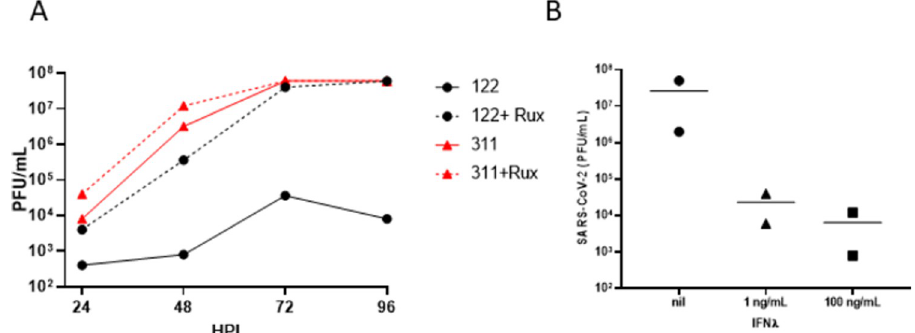
Fig 4. IFN signalling mitigates SARS-CoV-2 growth kinetics. WD-PNECs derived from donor 122 and SARS-Cov- 2-permissive donor 311 were treated basolaterally with 1 μ M ruxolitinib for 48 h, or left untreated, prior to infection with SARS-CoV-2 (MOI = 0.1). Ruxolitinib was replaced at 1 and 48 hpi. Apical washes were harvested every 24 h post infection until 96 hpi. SARS-CoV-2 viral growth kinetics were determined by plaque assay of apical washes on Vero cells (A). WD-PNEC cultures derived from SARS-CoV-2-permissive donor 311 were treated basolaterally in duplicate with 0, 1 or 100 ng/mL IFN λ for 24 h prior to infection with SARS-CoV-2 (MOI = 0.1). Apical washes were harvested at 48 hpi and titrated by plaque assay on Vero cells